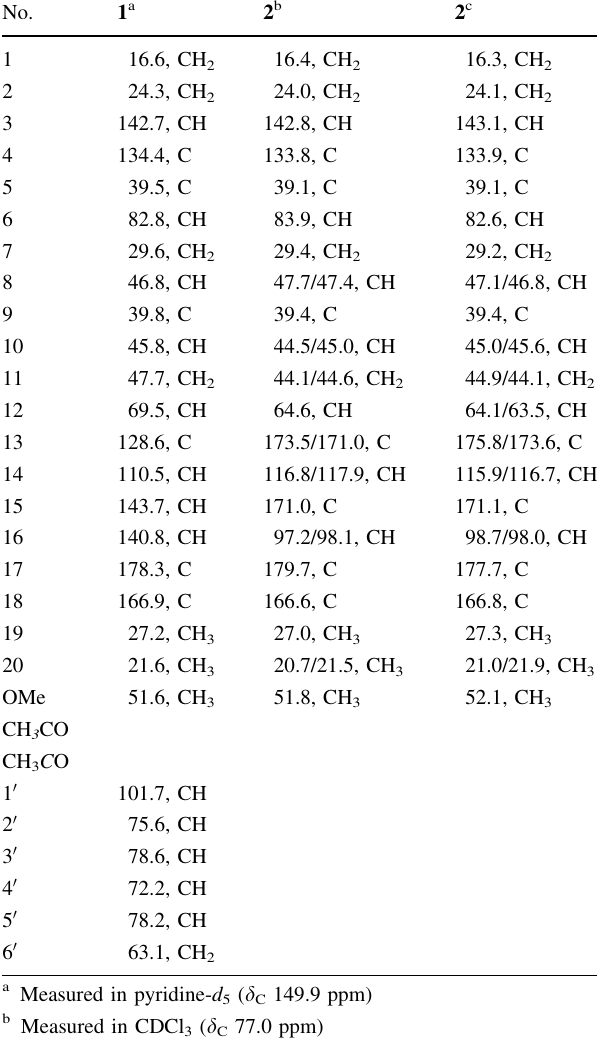
Table 2 13 C NMR spectroscopic data for 1 and 2